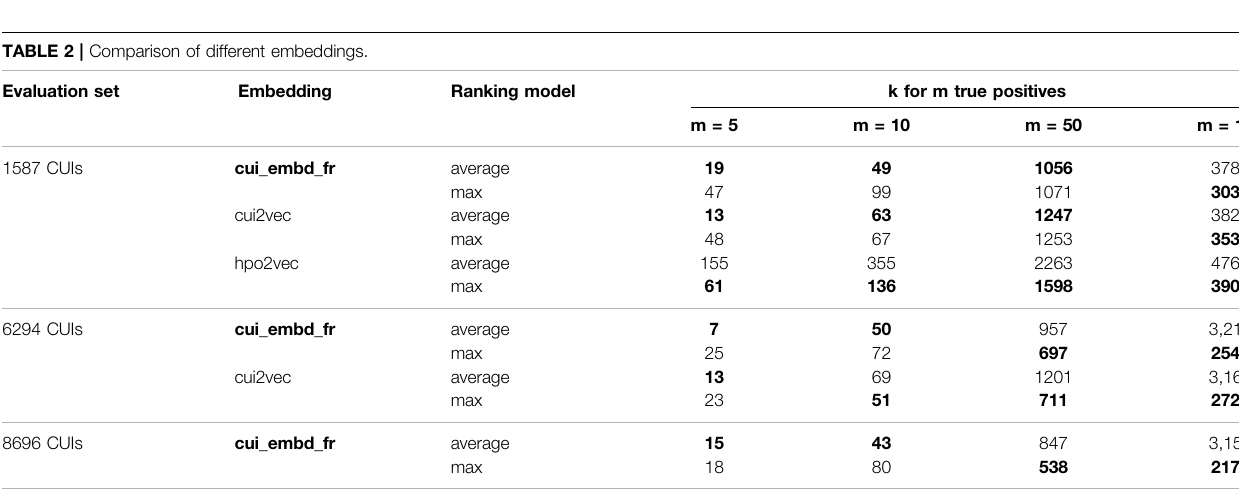
TABLE 2 | Comparison of different